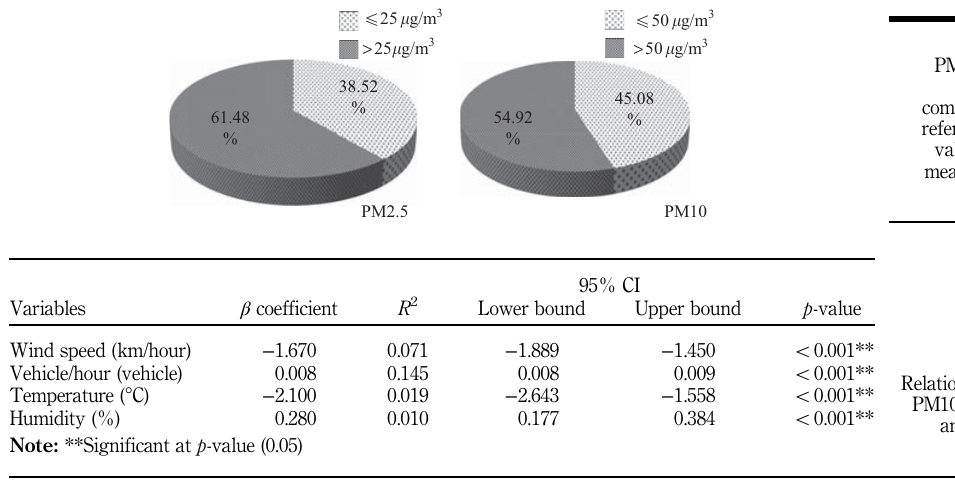
Figure 1. PM2.5 and PM10 concentration compared to WHO reference guideline value for